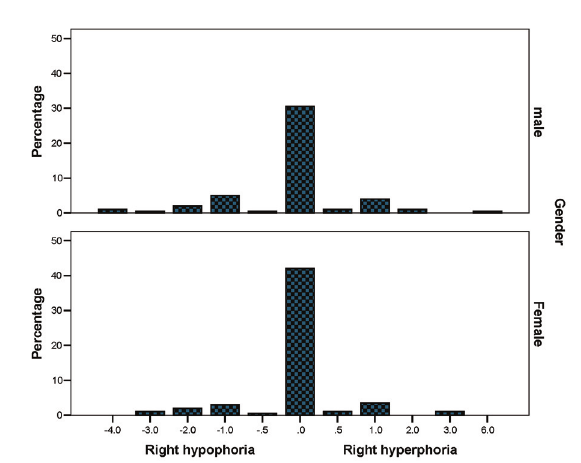
Figure 8 Distribution of near vertical heterophoria accord- ing to gender, showing greater orthophoria for both male and